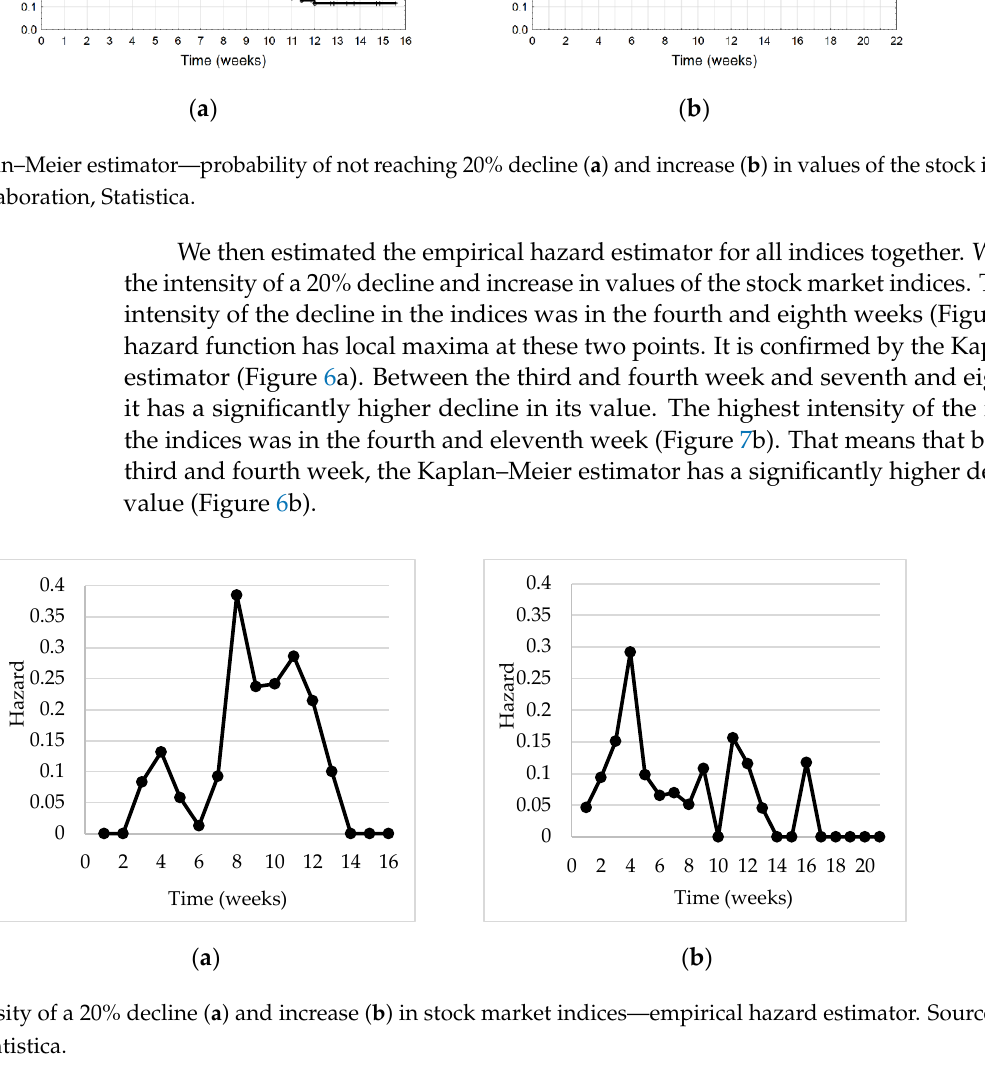
Figure 7. Intensity of a 20% decline ( a ) and increase ( b ) in stock market indices—empirical hazard estimator. Source: own elaboration, Statistica.